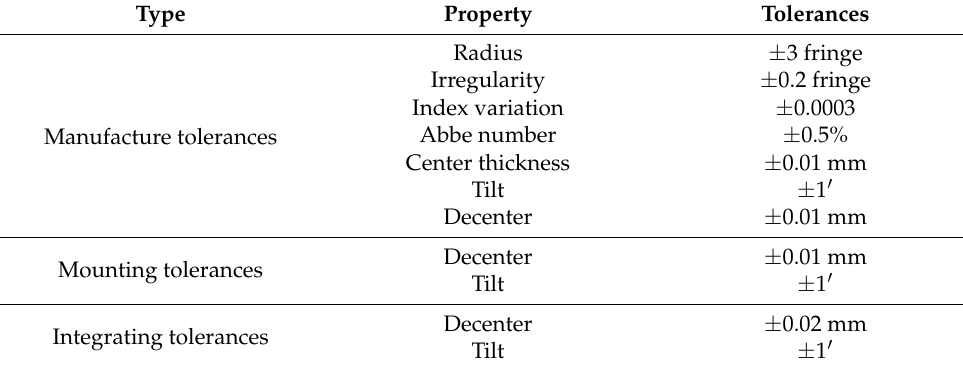
Table 4. Tolerances for the zoom lens system